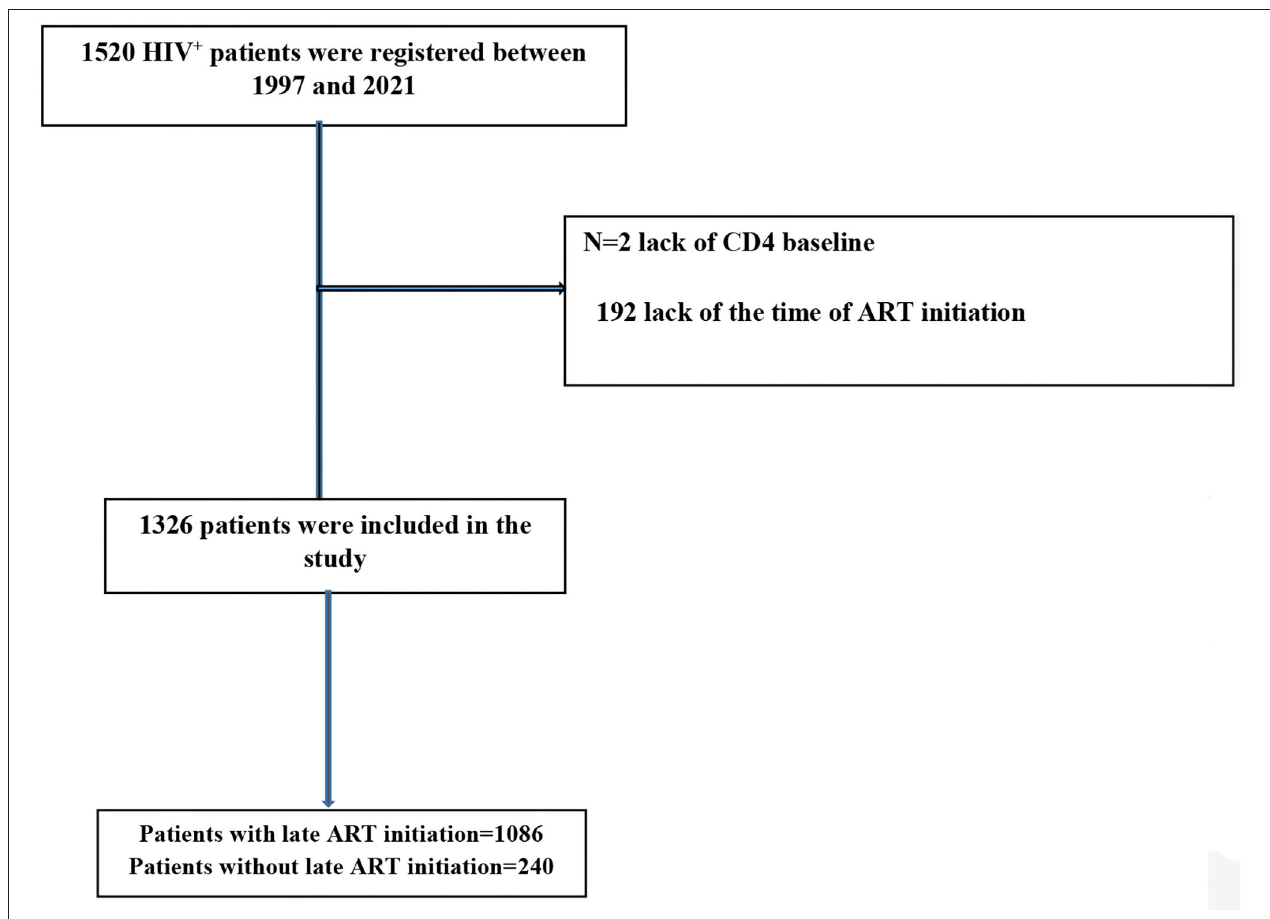
FIGURE 1 | The flow chart of participant’s selection.